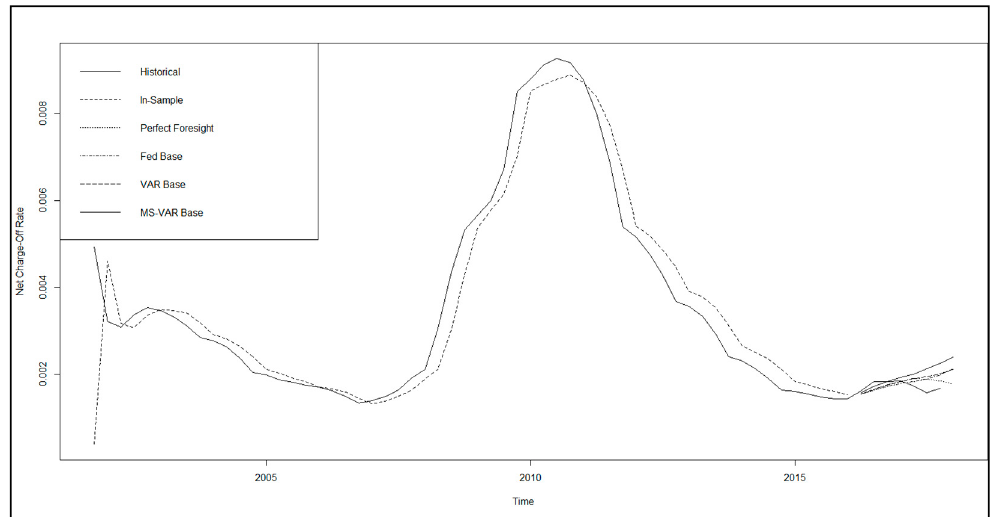
Figure 7. Net Charge-off Rate model accuracy plots—unemployment rate and BBB corporate—five-year treasury bond spread (FDIC SDI Report, Federal Reserve Board 4Q91–4Q15 and Jacobs (2018) models).